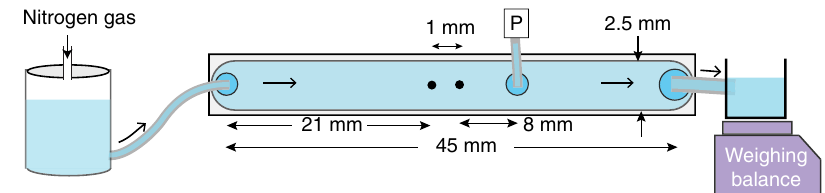
Fig. 1 Schematic of experimental setup. It consists of a linear channel of dimension L × w × h = 45 × 2.5 × 1 mm 3 with two cylindrical obstacles (shown as two black dots), diameter 2 R = 0.3 mm and separated by a distance between the obstacles centers e = 1 mm, embedded at the center line of the channel. The polymer solution is driven by Nitrogen gas and injected through the inlet into the channel. The fl uid exiting the channel outlet is weighed instantaneously as a function of time. An absolute pressure sensor, marked as P , after the downstream cylinder is employed to detect pressure fl